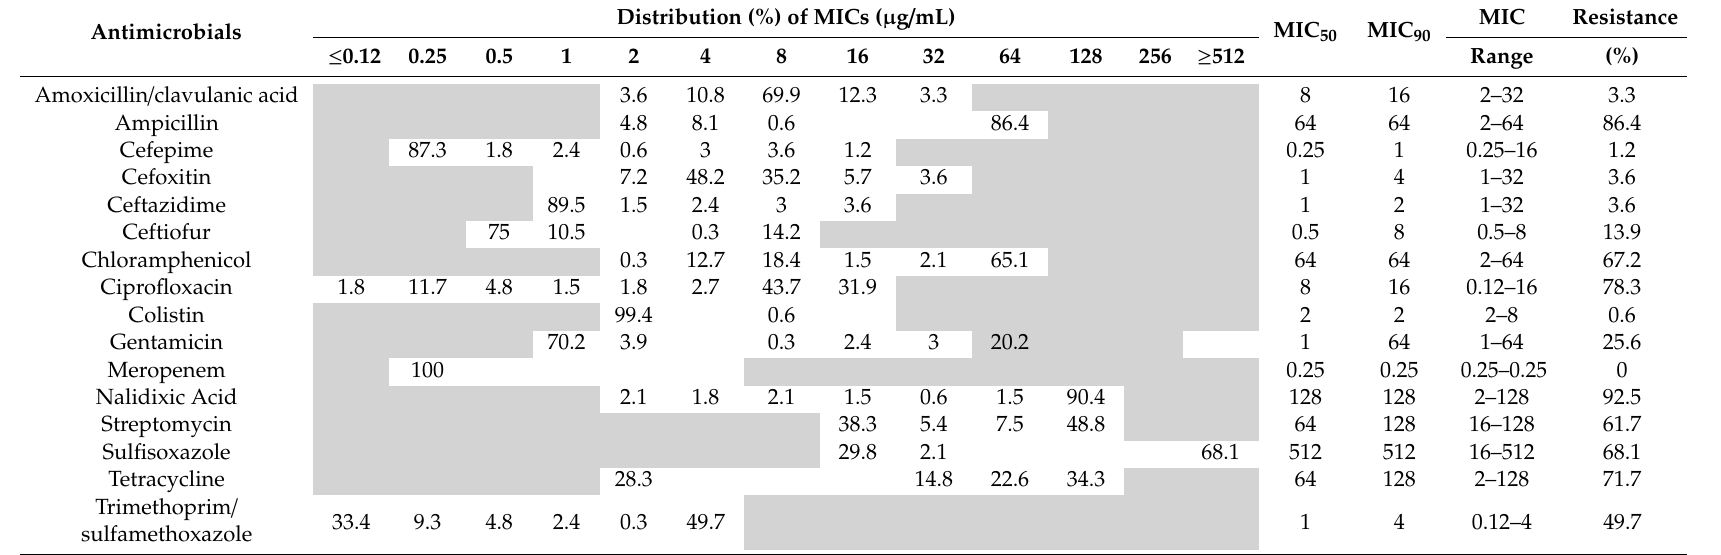
Table 1. Antimicrobial resistance profiles and MIC distribution of Escherichia coli isolated from healthy broiler chickens in Korea.